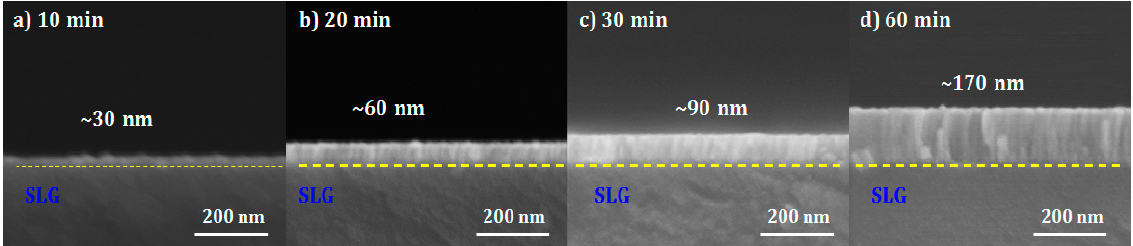
Figure 3. Cross-sectional SEM images of SLG/i-ZnO prepared with different deposition times: ( a ) 10 min, ( b ) 20 min, ( c ) 30 min, and ( d ) 60 min.